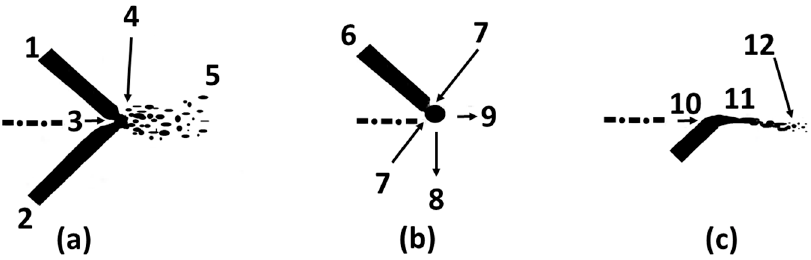
Figure 1. ( a ) Scheme of the arc spray process (ASP) principle. 1—positive wire; 2—negative wire; 3—atomizing gas direction; 4—molten material; 5—plume; ( b ) Forces acting during droplet formation on positive wire: 6—surface tension; 7—Pinch Effect; 8—droplet weight; 9—drag by the atomizing gas; ( c ) Formation of droplets on negative wire: 10—atomizing gas direction; 11—heat source or